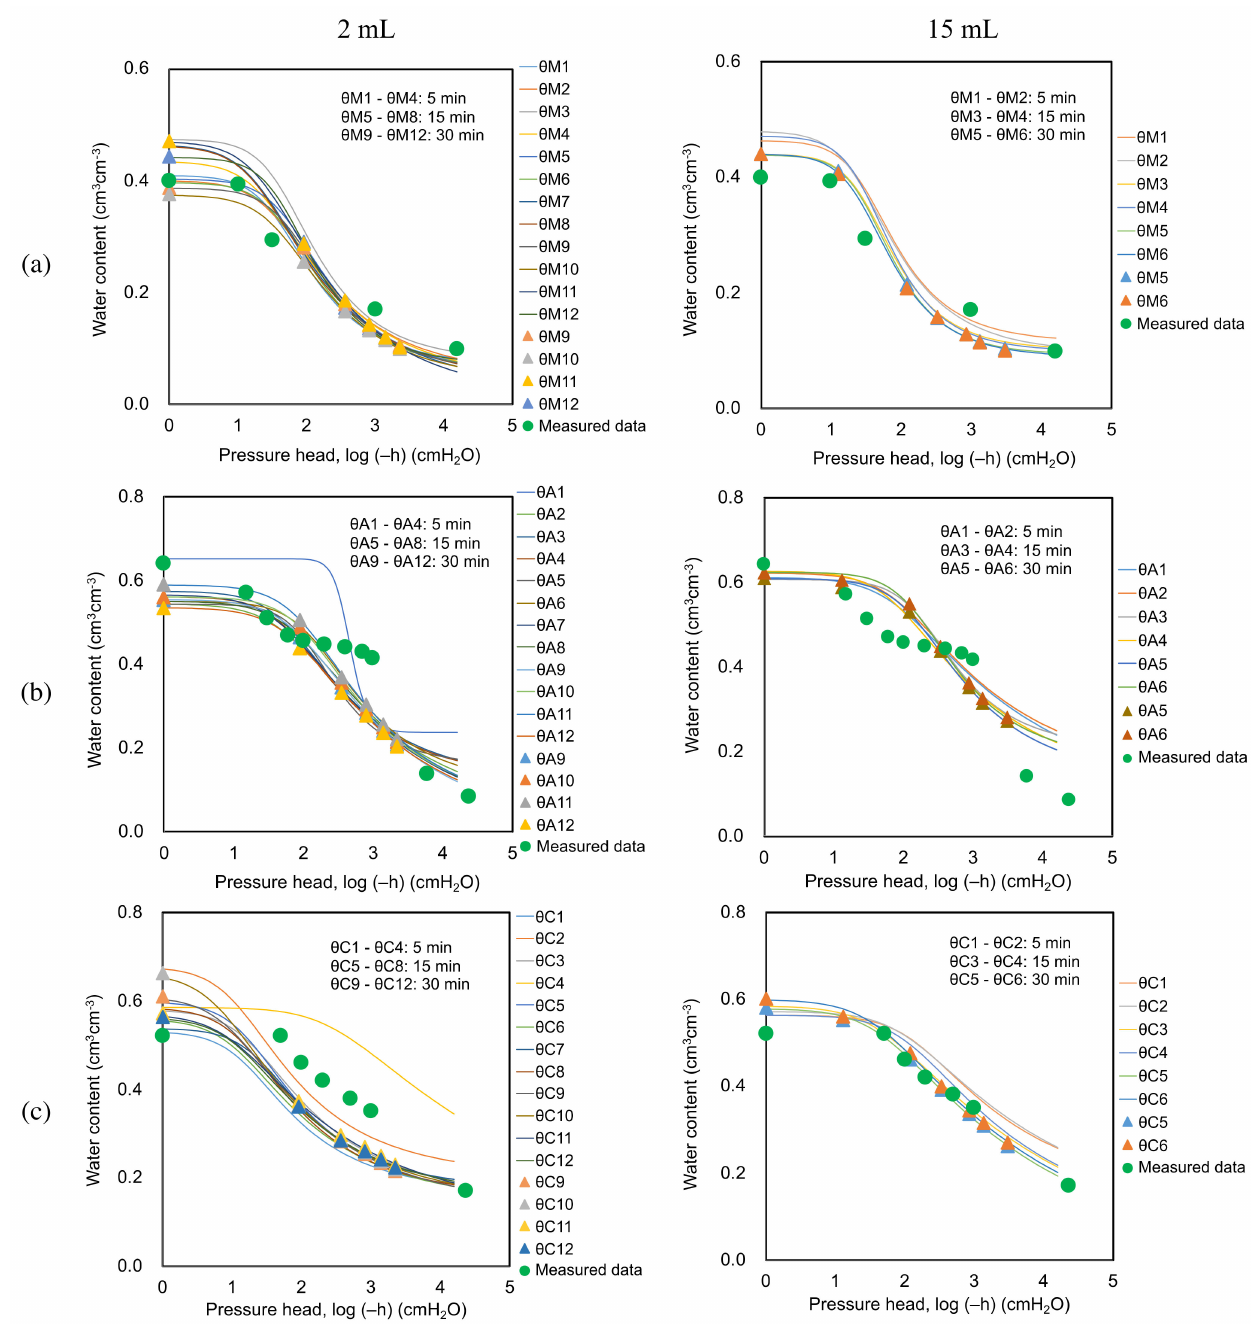
Figure 5. Optimized water retention and measured 30-min water content of 2 mL and 15 mL tubes ( a ) Decomposed granite soil (Masa soil); ( b ) Volcanic ash soil (Andisol soil); ( c ) Paddy soil ( (cid:52) : equilibrium data; —: optimized data; : Pressure-plate (cid:35)